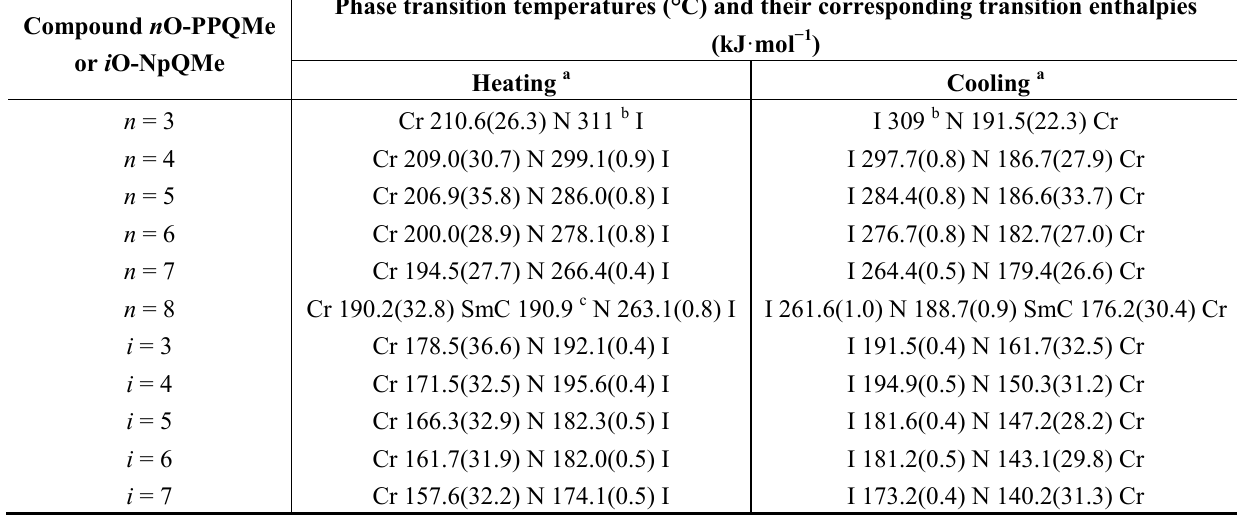
Table 2. Phase transition temperatures (°C) and corresponding transition enthalpies (kJ·mol − 1 ), in parentheses, for homologous series of n O-PPPQMe, n = 3–8, and i O-NpQMe, i =